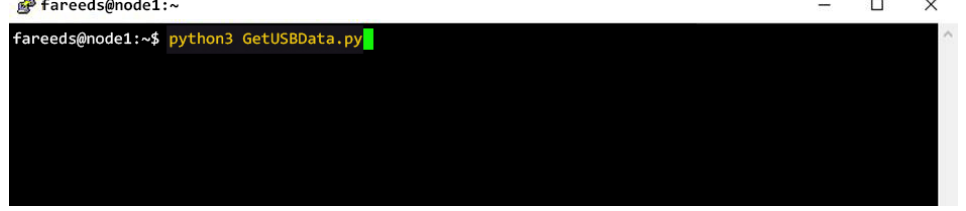
Figure 13. Command line interface with malware command executed for stealing the private keys .